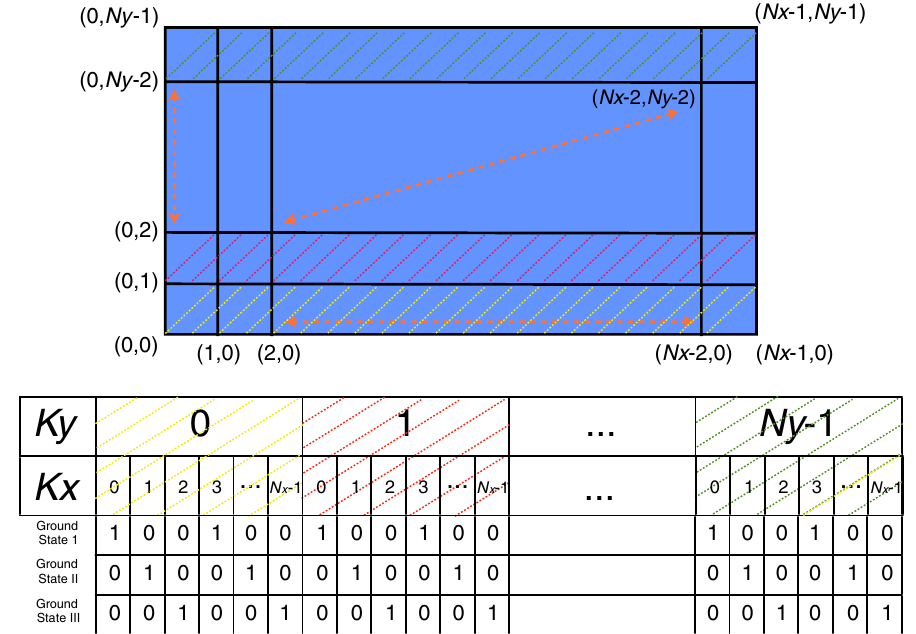
FIG. 9. Momentum of the 3-fold degenerate ground state for the fractional Chern insulator at filling (cid:1) ¼ 1 = 3 . The 2-dimensional lattice of momenta k x ; k y with k x 2 ½ 0 ; N x (cid:2) 1 (cid:3) and k y 2 ½ 0 ; N y (cid:2) 1 (cid:3) (in units of 2 (cid:4)=N x , 2 (cid:4)=N y , respectively) where we have taken N N N 3 N , this can always be done) is unfolded in a 1D lattice. The total momentum of the ground x to be a multiple of 3 (since x (cid:5) y ¼ states is then the same as the momentum of the three (1,3)-admissible partitions possible for the number of orbitals N x (cid:5) N y and number of particles N ¼ N x (cid:5) N y = 3 . 1-dimensional lattice of orbitals of momentum (cid:8) ¼